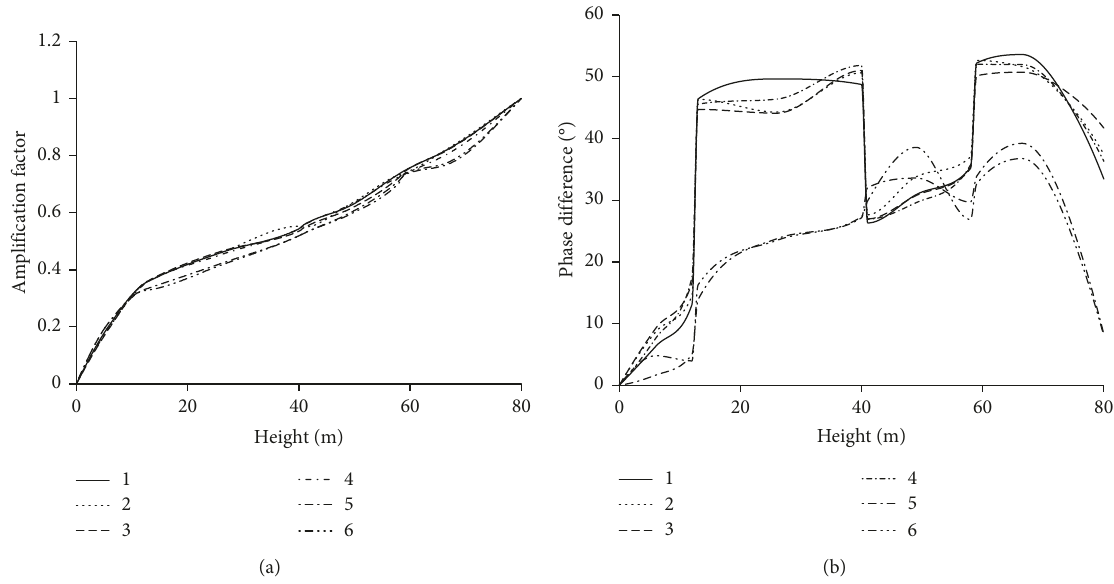
Figure 4: Vibration modes and phase differences of the No. 1 wind turbine tower. (a) The first-order vibration mode under six working conditions. (b) The first-order phase difference under six working conditions.